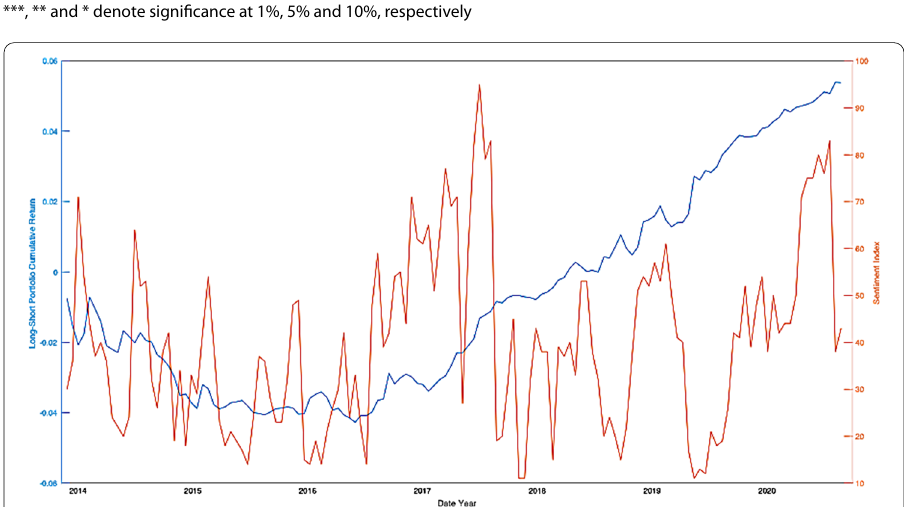
Fig. 1 Long-short portfolio cumulative return and sentiment